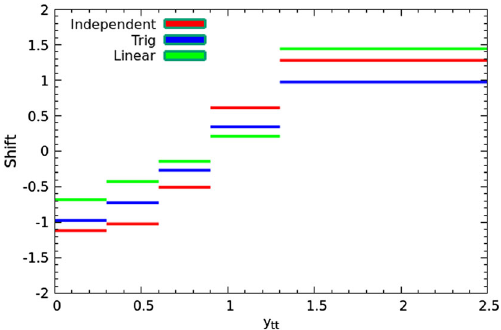
Fig. 5 Values for individual shift parameters ( λ i in Eq. (1)) for the partonshowererrorwhenfittingthe y tt distributionoftheATLAS8TeV lepton + jet data, while decorrelating the error between each data